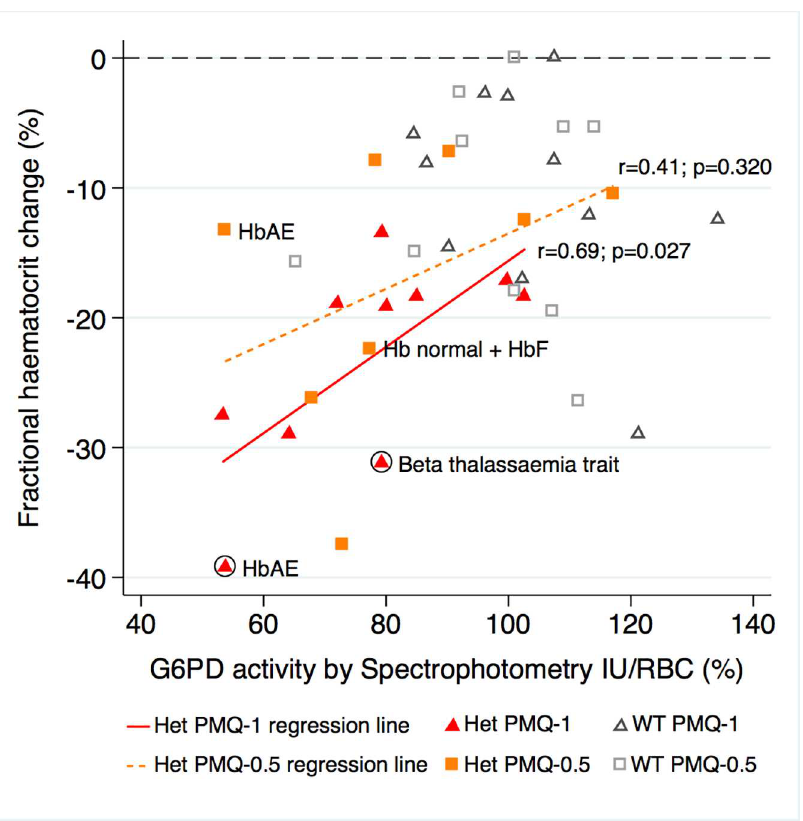
Fig 4. Correlation between maximum individual fractional haematocrit reduction and mean G6PD activity (IU/RBC) * . * ThreeG6PD heterozygous females with missing data. The difference between the regression lines for heterozygote PMQ-1 and heterozygote PMQ-0.5 was not statistically significant ( p = 0.433). The haemoglobin type was normalunless otherwiseindicated.Circledshapes represent participants who received a blood